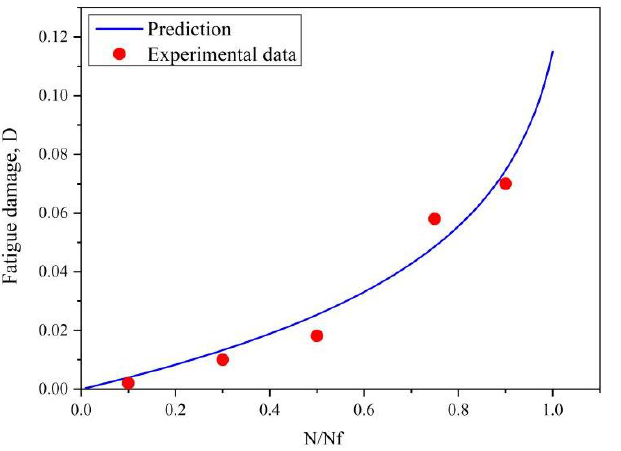
Figure 16. Comparison of the prediction of fatigue damage and experimental data under 950 MPa stress.